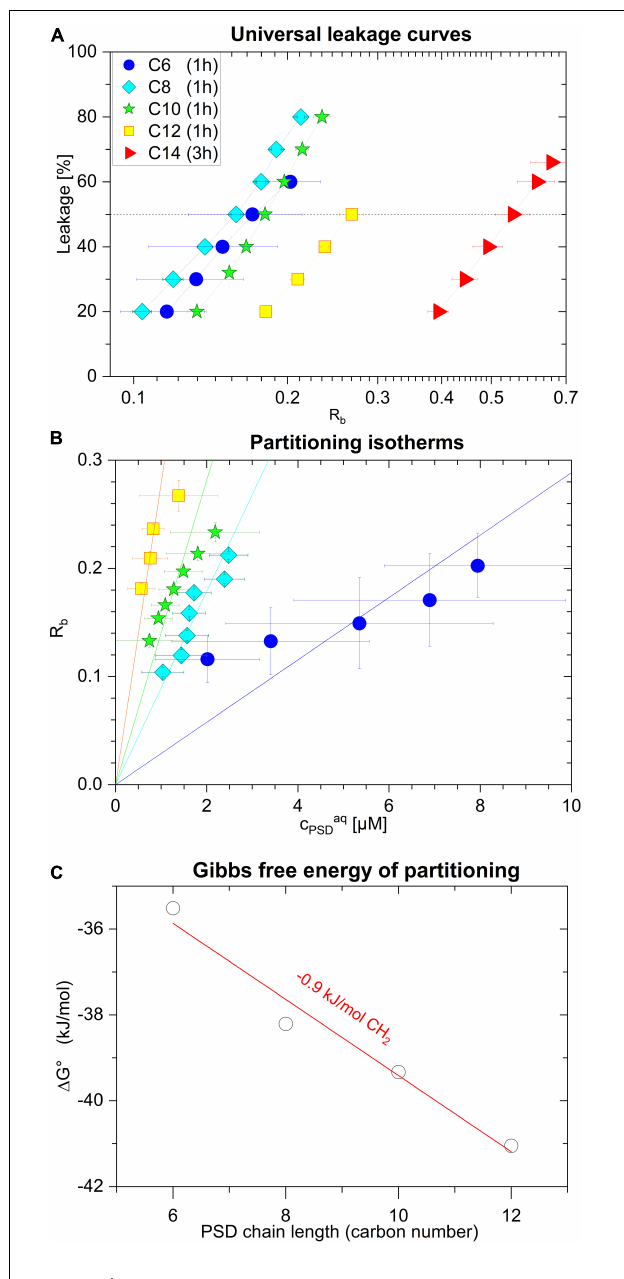
FIGURE 6 | Leakage of calcein-LUVs after 1 h incubation time induced by PSD-C6 (blue circle), PSD-C8 (cyan diamond), PSD-C10 (green star), and PSD-C12 (yellow square), and after 3 h incubation time induced by PSD-C14 (red triangle), as a function of the mole ratio within the lipid membrane, R b (A) . R b as a function of free PSD (c PSDaq ) describing membrane partitioning for C6, C8, C10, and C12 analogs (B) . The standard Gibbs free enthalpy of partitioning, (cid:49) G ◦ , as a function of the PSD chain length along with a linear fit suggesting a methylene group contribution of – 0.9 kJ/mol (C) . Error bars indicate standard errors of the equi-activity fit as illustrated in Figure 5